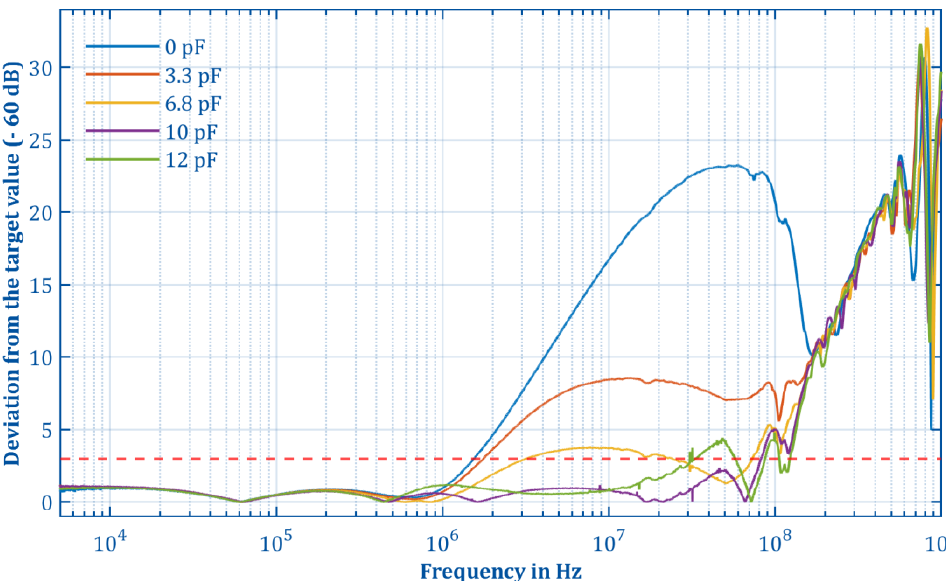
(purple) are shown.